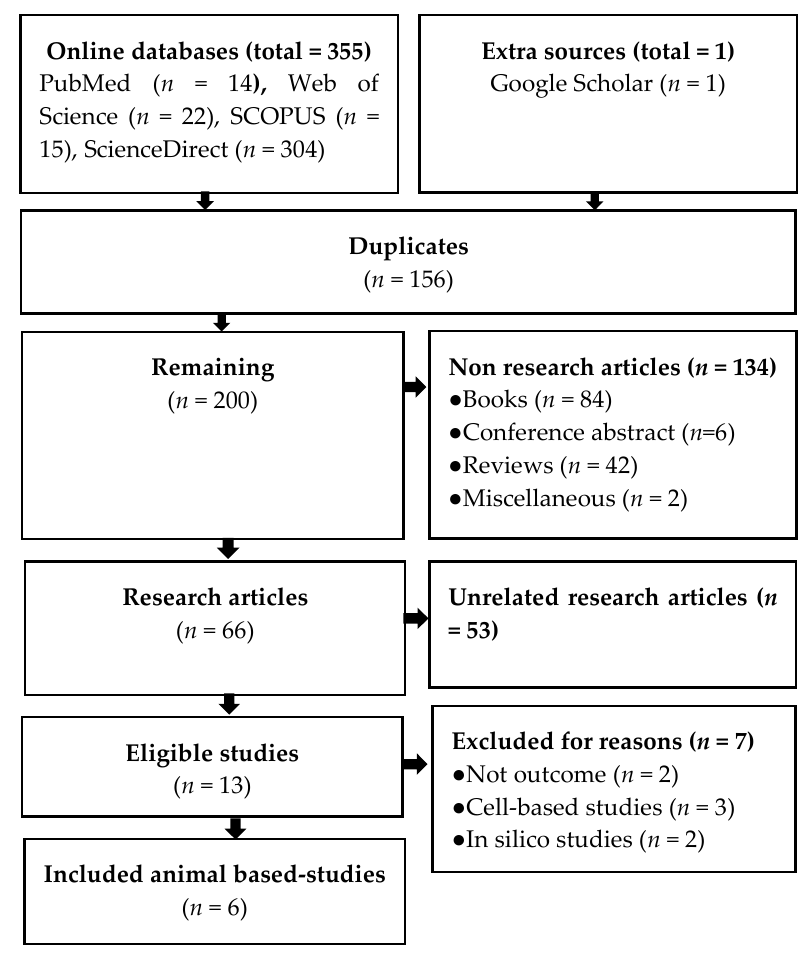
Figure 1. PRISMA flow diagram.